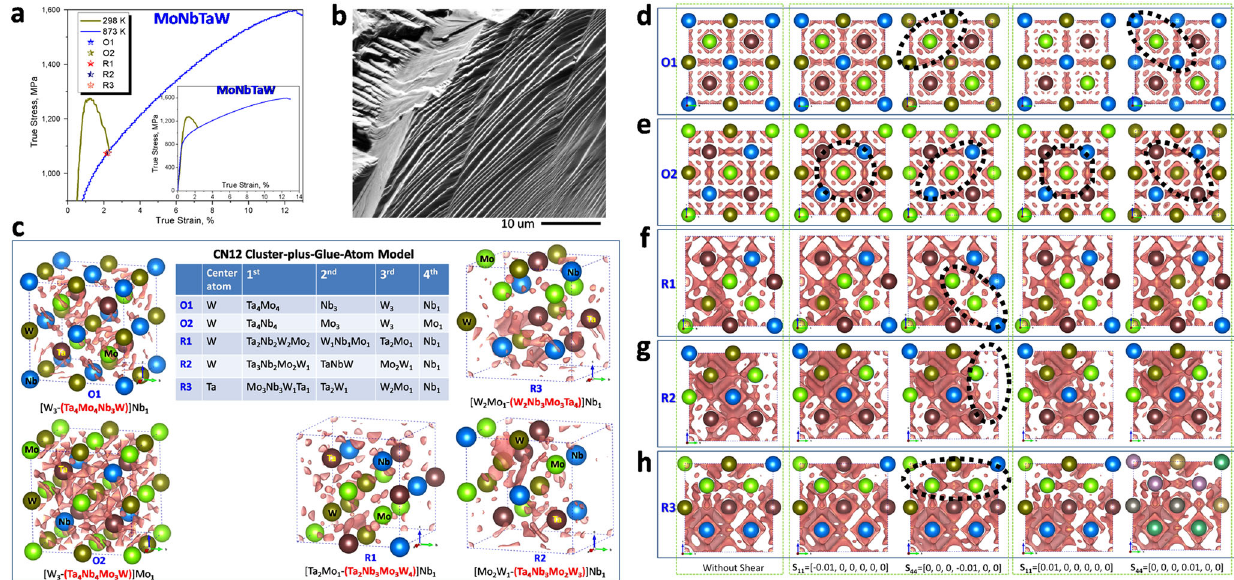
Fig. 2 Structure-dominated compressive property of the BCC MoTaNbW HEA. a The stress – strain curve at a strain rate of 1 × 10 − 3 s − 1 during compressive testing. The various symbols present the corresponding stress states of the invested con fi gurations. b SEM image of the compression fracture surface at room temperature, 298 K, representing a viscous- fl ow-dominated plastic-deformation behavior (assuming that the weak spots follow a Newtonian- fl ow behavior with an average viscosity 25, 52 ). c Bonding-charge-density isosurface ( Δ ρ = 0.009 e - Å − 3 ) of con fi gurations of [W 3 - (Ta 4 Mo 4 Nb 3 W 1 ) ]Nb 1 (labeled as O1), [W 3 - (Ta 4 Nb 4 Mo 3 W 1 ) ]Mo 1 (labeled as O2), [Ta 2 Mo 1 - (Ta 2 Nb 3 Mo 3 W 4 ) ]Nb 1 (labeled as R1),